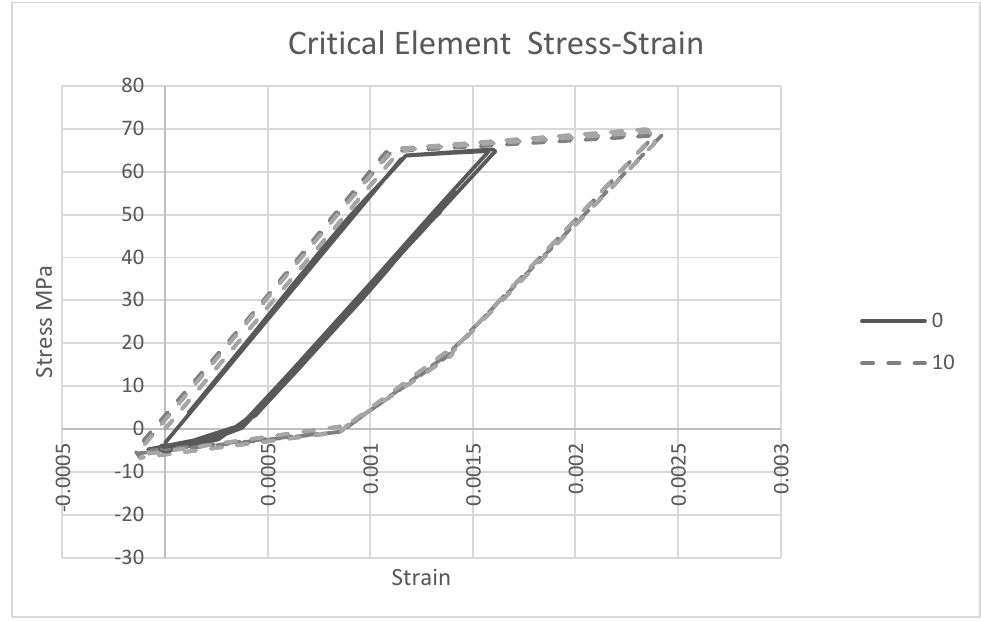
Fig. 18. The stress-strain curve at the critical point of the joint node.